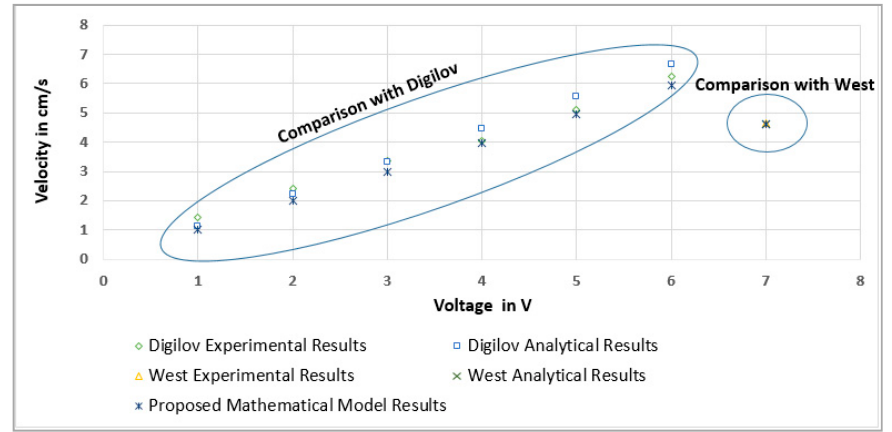
Figure 5. Digilove [16] and West [17] Analitycal and Experimental Results vs. Proposed Mathematical Model Results.